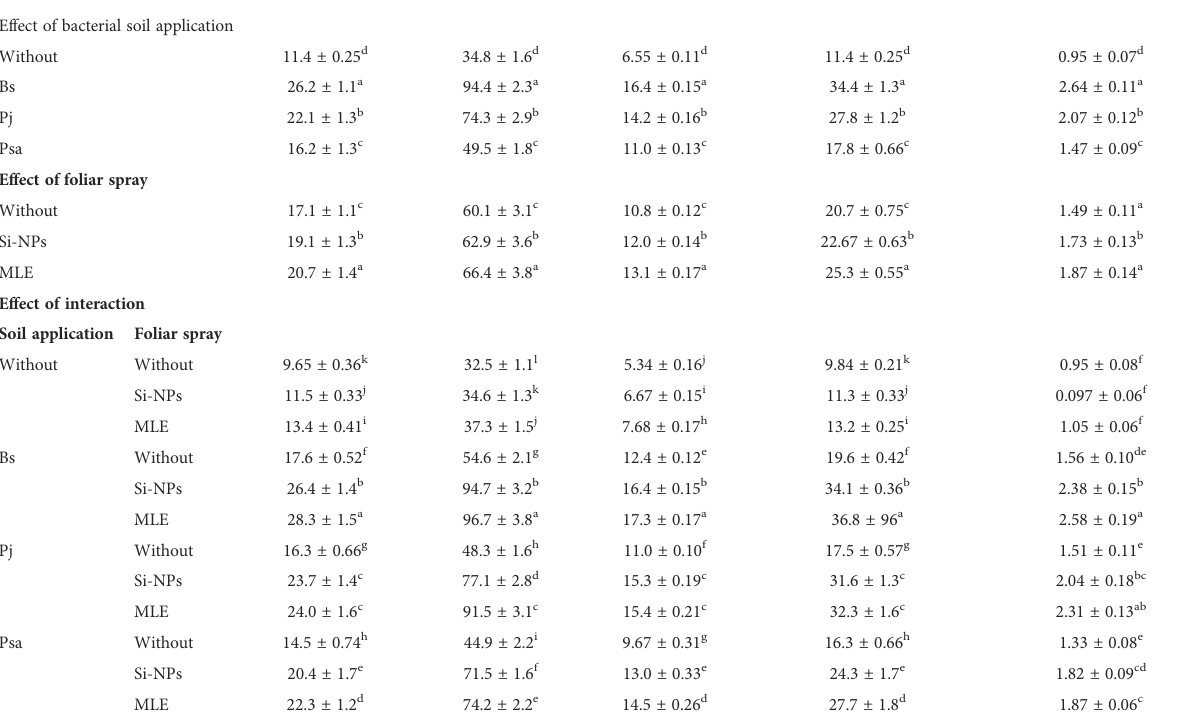
TABLE 3 Changes in growth attributes of heavy metal – stressed spinach plant in response to bioremediation of heavy metals bacterial applied as soil inoculation and/or foliar spray with MLE or